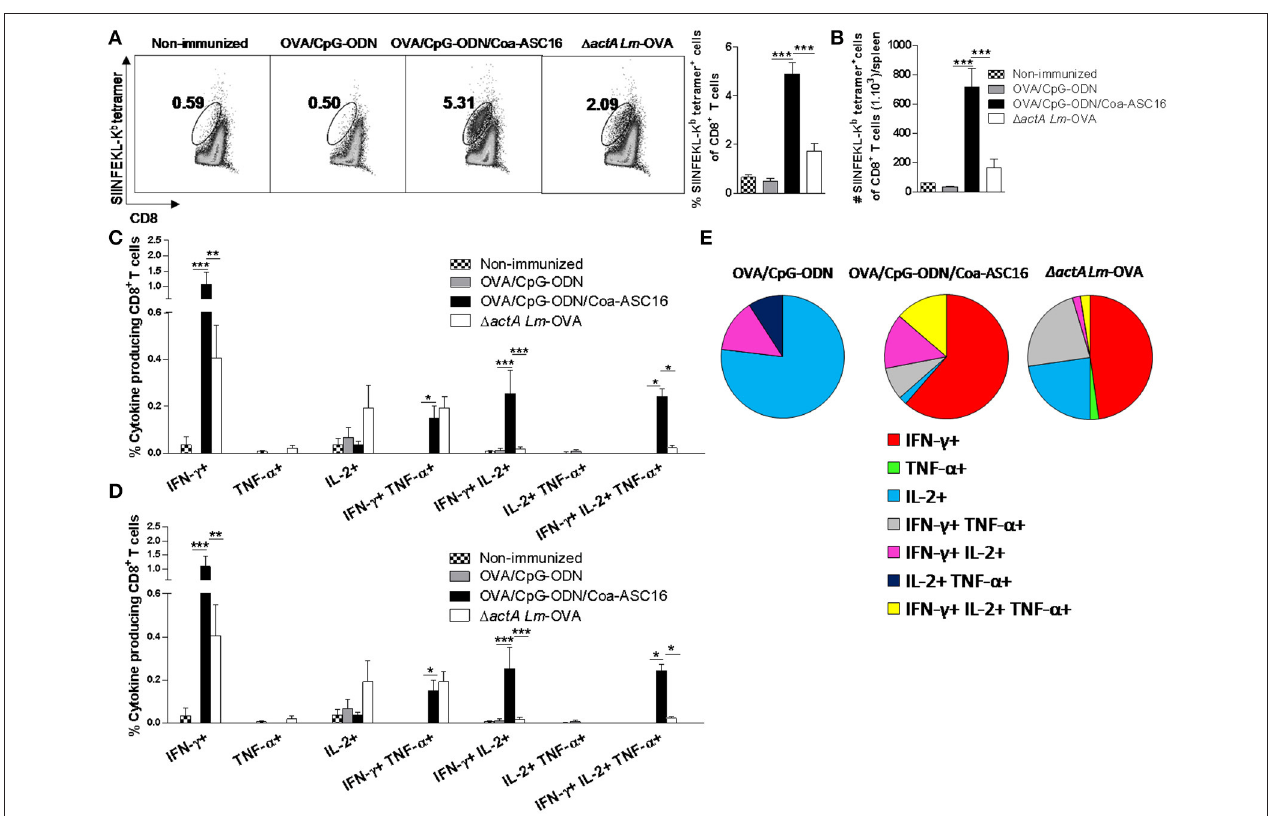
FIGURE 7 | The formulation of OVA/CpG-ODN with Coa-ASC16 enhances expansion and polyfunctionality of effector CD8 + T-cells. C57BL/6 mice were immunized on day 0 with OVA/CpG-ODN, OVA/CpG-ODN/Coa-ASC16 or 1 actA Lm- OVA and euthanized on day 7 for spleen extraction. (A) Percentage of SIINFEKL-K b tetramer + CD8 + T-cells. (B) Total number of SIINFEKL-K b tetramer + CD8 + T-cells/spleen. (C–E) CD8 + T-cell cytokine production from splenocytes after in vitro stimulation with SIINFEKL peptide. Multiparameter flow cytometry was used to determine (C) percentage and (D) total number of cytokine producing CD8 + T-cells expressing each of the seven possible combinations of IFN- γ , TNF- α , and IL-2, (E) fraction of total CD8 + T-cell response comprising cells expressing each of the seven combinations of IFN- γ , TNF- α , and IL-2. For gating strategy and representative flow cytometry data, see Supplementary Figure 3 . The data show the mean ± SEM of individual values (4 mice/treatment group in each experiment) and are representative of two independent experiments performed. * p < 0.05, ** p < 0.01, *** p <